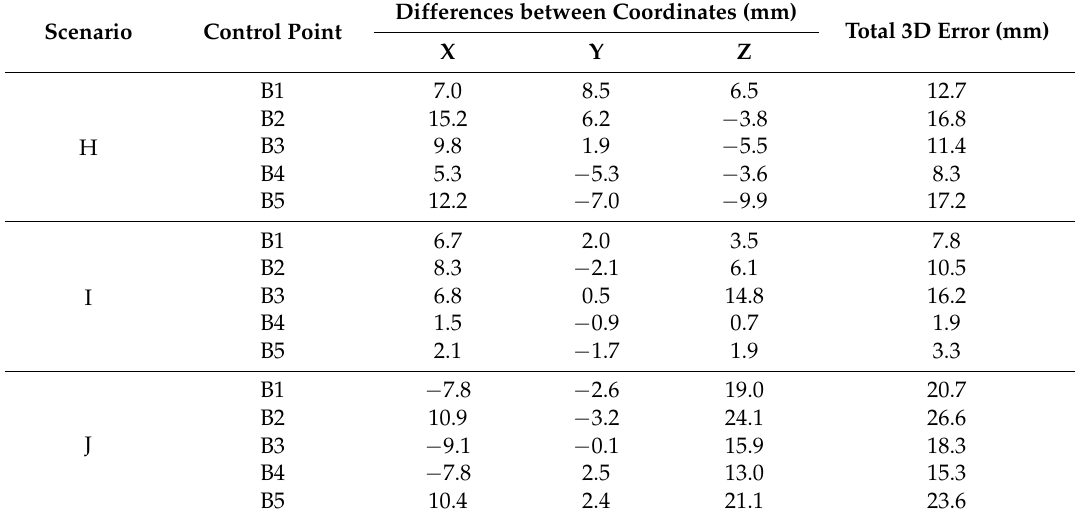
Table 2. Differences in mm between the coordinates of the control points obtained from the total station and the coordinates of the same control points extracted from the digital photogrammetry point